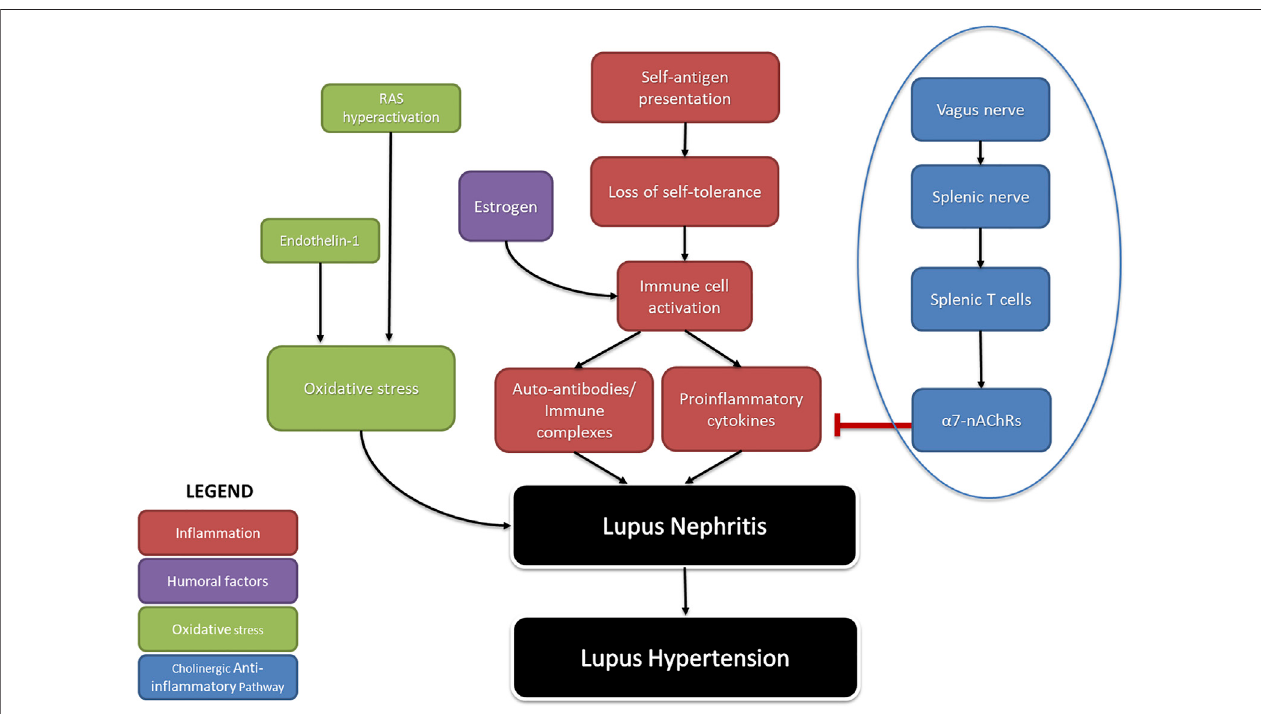
FIGURE 1 | The pathophysiology of SLE-induced hypertension: A summary of factors that contribute to hypertension in SLE. In fl ammation due to autoimmunity (red), as well as humoral factors that increase it (purple), and aberrant activity causing oxidative stress (green) comprise endogenous causes of lupus hypertension. The cholinergic anti-in fl ammatory pathway (blue) represents a neurogenic cause of lupus hypertension. Arrows ( → ) indicate stimulation; line with fl athead (--|) indicates inhibition (RAS- renin angiotensin system; α 7nAchRs-alpha seven nicotine acetyl choline receptors).